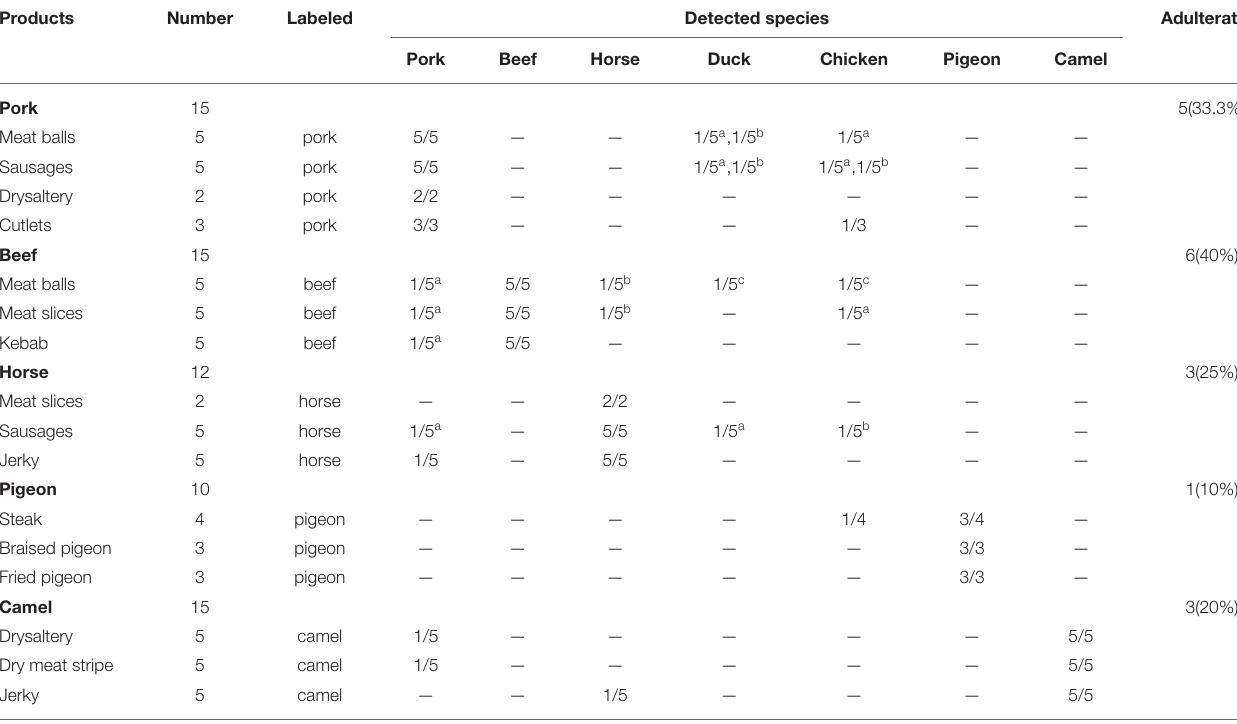
TABLE 2 | Results of multiplex PCR assay performed on commercial meat products.